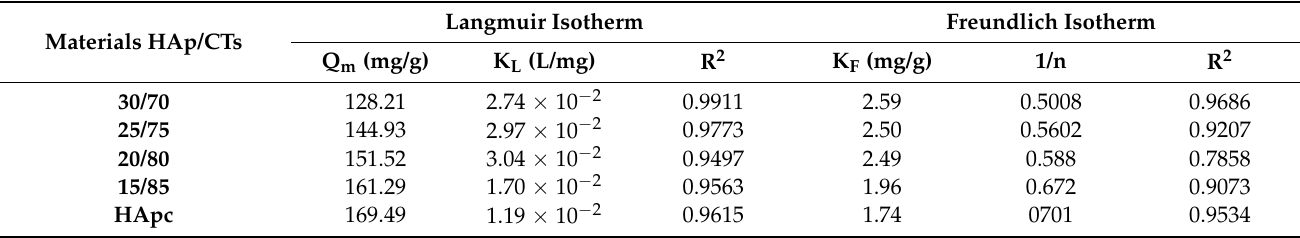
Table 2. Parameters of Cd 2+ adsorption isotherms on the composites.